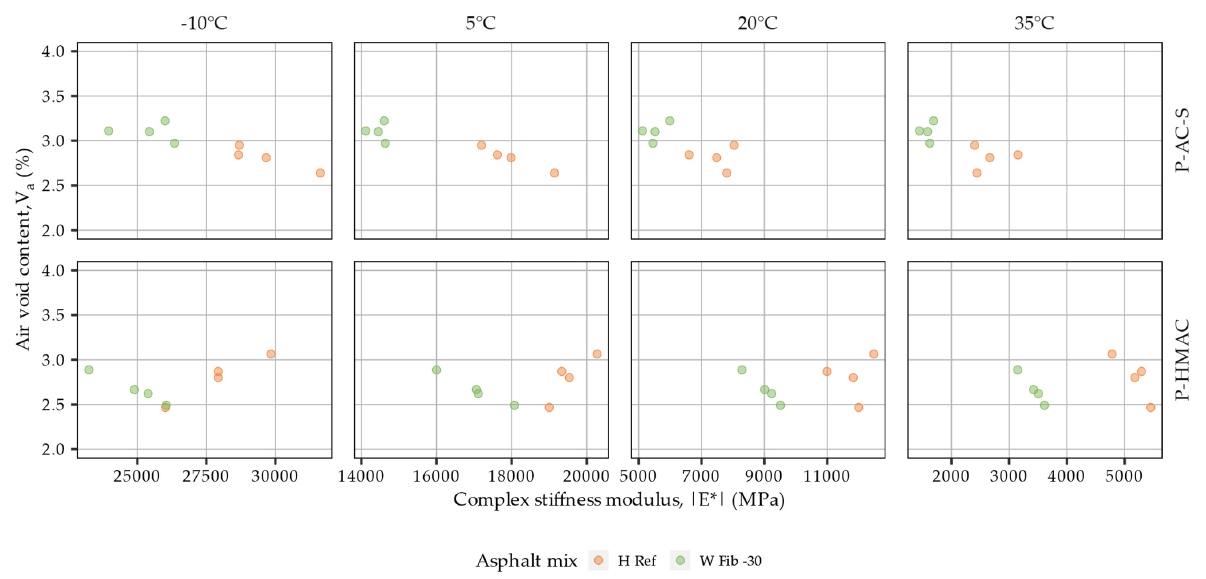
Figure 10. Complex stiffness moduli measured at 10 Hz versus air void content in plant produced samples from surface course and high modulus asphalt concrete.